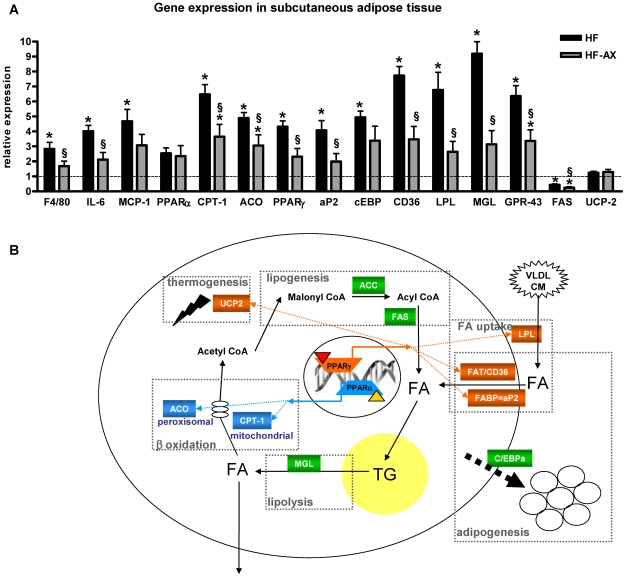
mRNA levels of key factors and metabolic network in the subcutaneous adipose tissue.Expression of genes involved in subcutaneous adipose tissue metabolism (A). Mice were fed a standard (CT), a high fat diet (HF) or a high fat diet supplemented with 10% arabinoxylan (HF-AX) for 4 weeks. Values are expressed relative to CT group (set at 1). *p<0.05 versus CT and §p<0.05 versus HF (ANOVA). Genes that regulate metabolic processes in white adipose tissue (B); some of them are dependent on PPARα (blue) or PPARγ (orange) activation by an endogenous ligand. PPARγ, peroxisome proliferator-activated receptor γ; aP2, adipocyte fatty acid binding protein; C/EBPα, CCAAT enhancer binding protein α; GPR43, G protein-coupled receptor 43; LPL, lipoprotein lipase; CD-36, cluster of differenciation 36; FAS, Fatty acid synthase; ACC, AcylCoa carboxylase; PPARα, peroxisome proliferator-activated receptor-alpha ; CPT-1, carnitine palmitoyl transferase-1 ; ACO, AcylCoA oxydase; MGL, monoacylglycerol lipase; UCP-2, uncoupling protein-2; VLDL, very low density lipoprotein; CM, chylomicron; FA, fatty acids; TG, triglycerides.